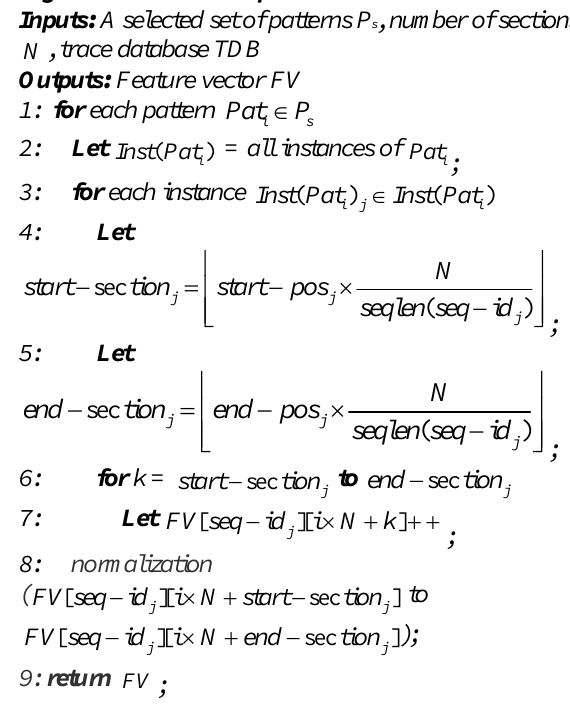
Algorithm 2: feature representation